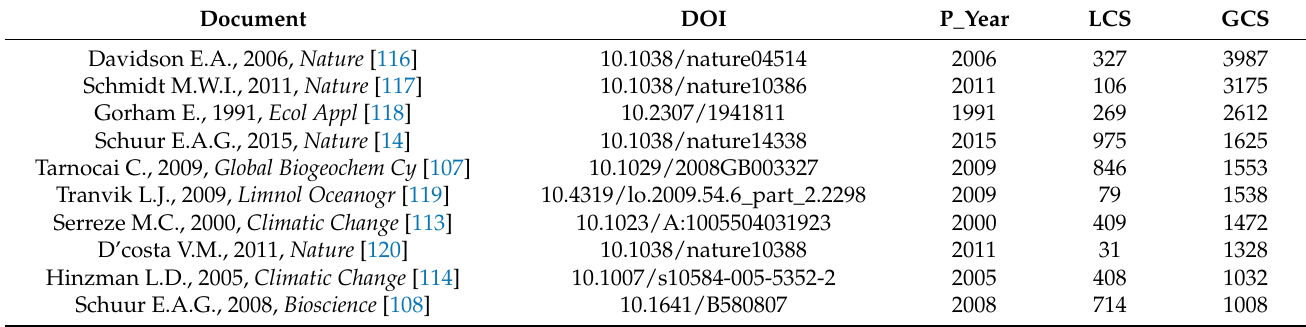
Table 8. Top 10 documents ranked by the global citation